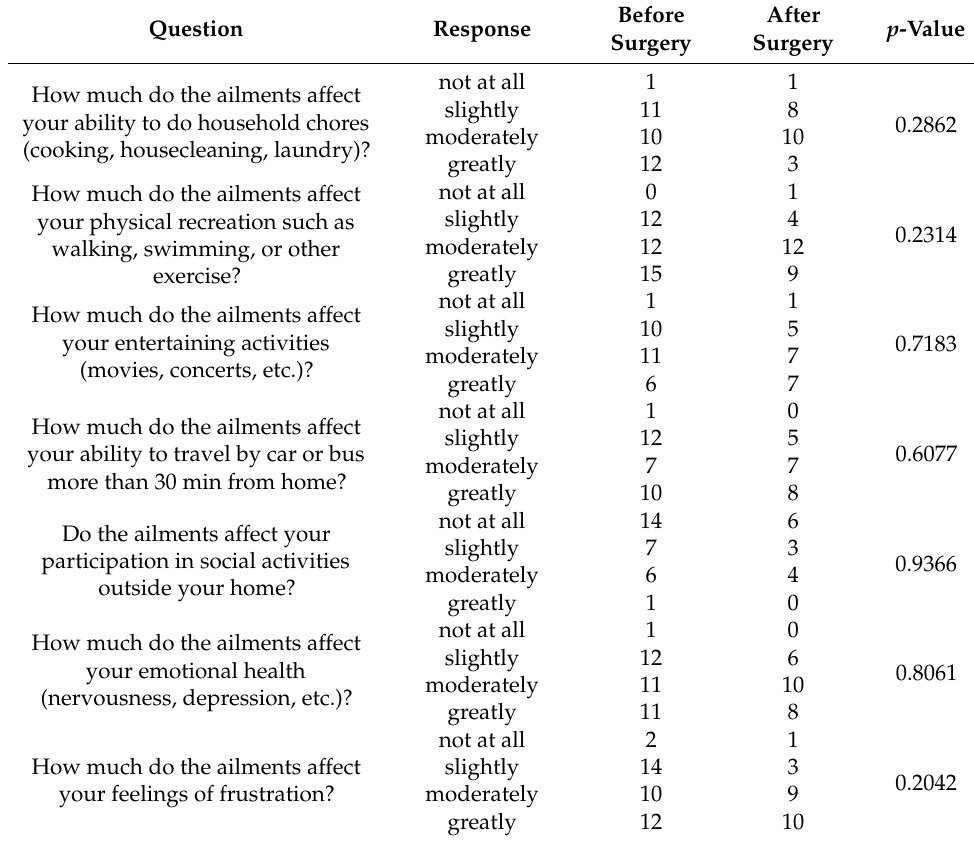
Table 2. Responses from IIQ-7 questionnaire from women before and after surgery.